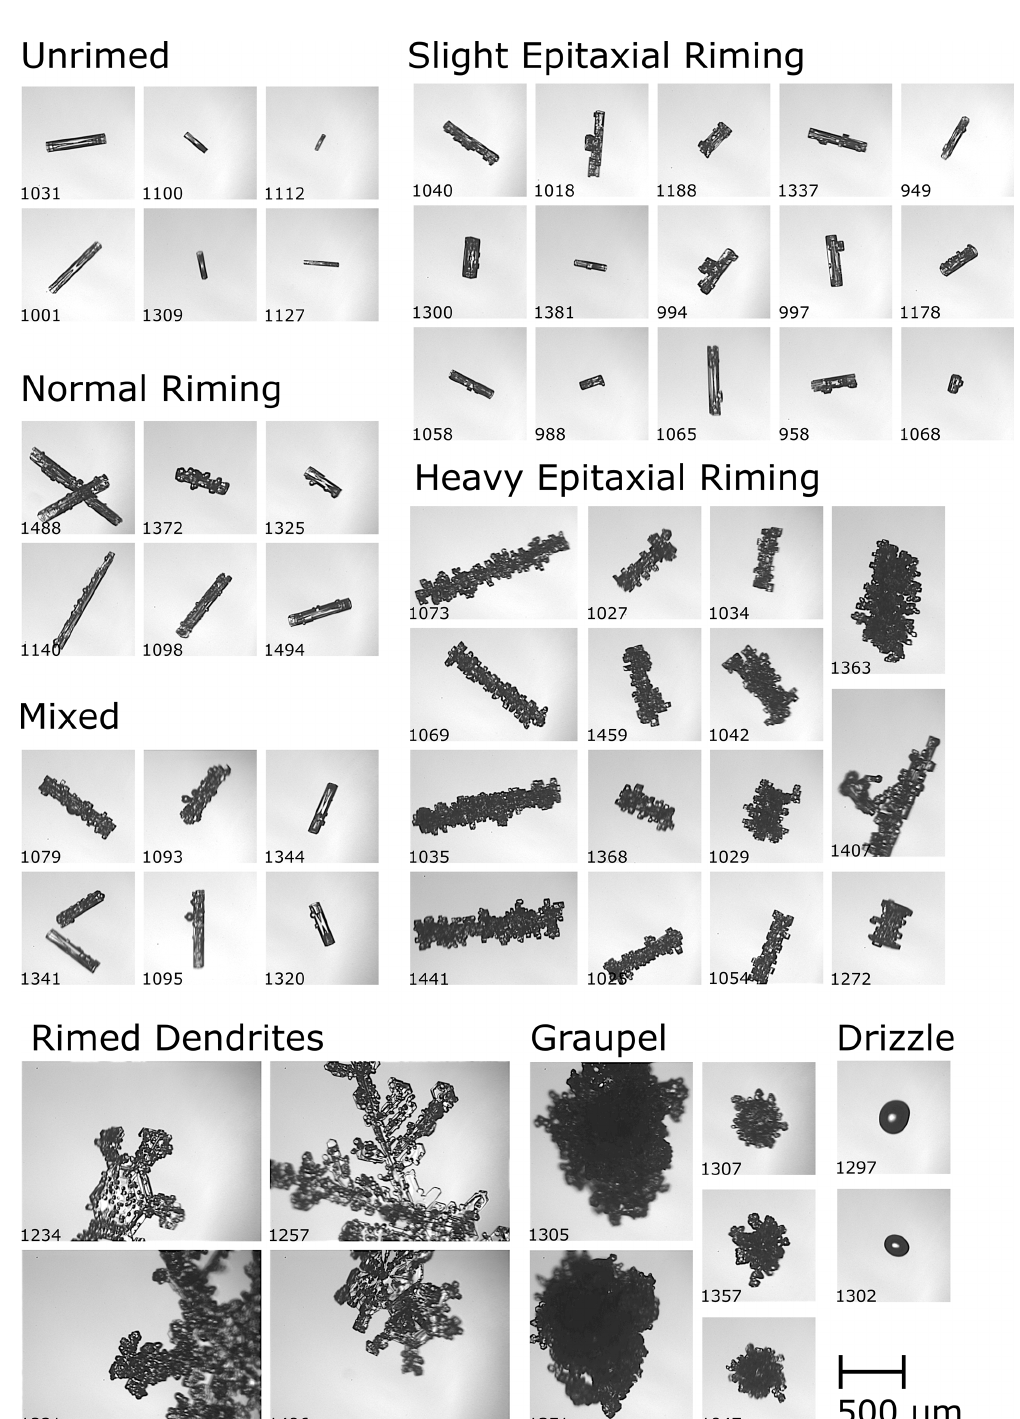
Figure 11. Corresponding representative PHIPS images of particles sampled during the segment indicated by the dashed black lines in Fig. 10. The numbers in the bottom left denote the image